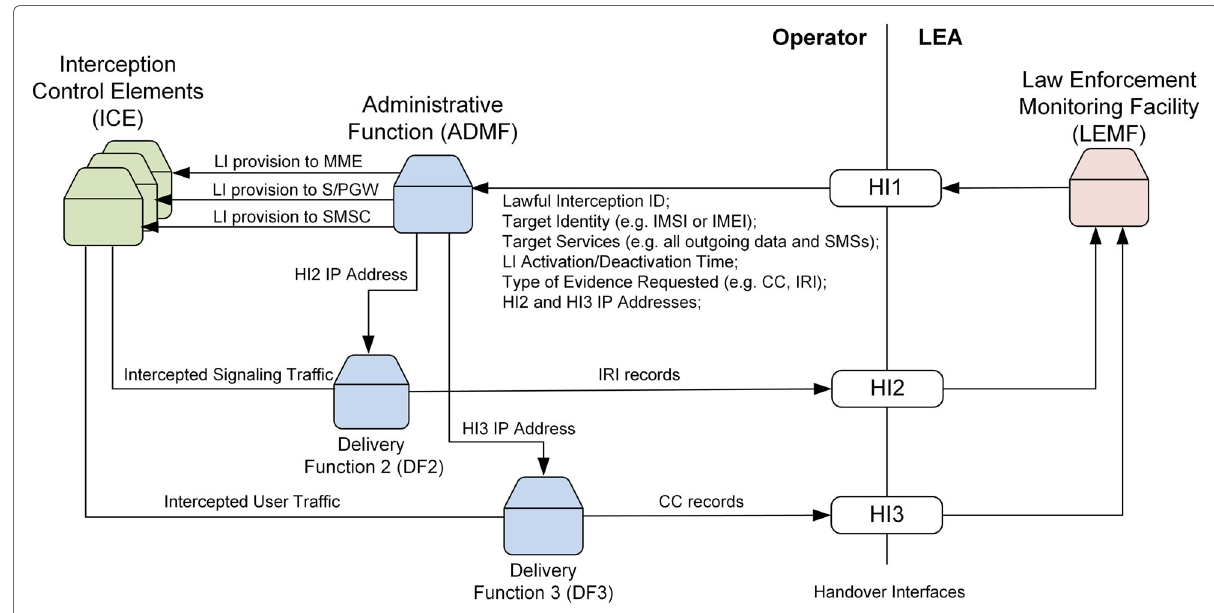
Fig. 1 The LTE/LTE-Advanced LI architecture. The handover interfaces between the operators and the LEA enable both real-time and non-real-time cellular network evidence identification, acquisition, and